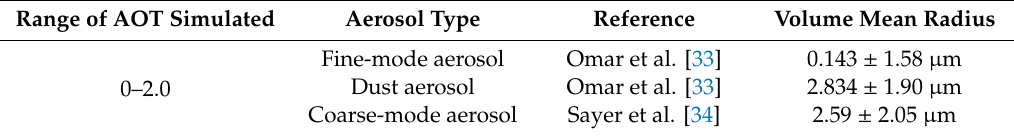
Table 4. Summary of the aerosol model types used in the GCOM-C retrieval